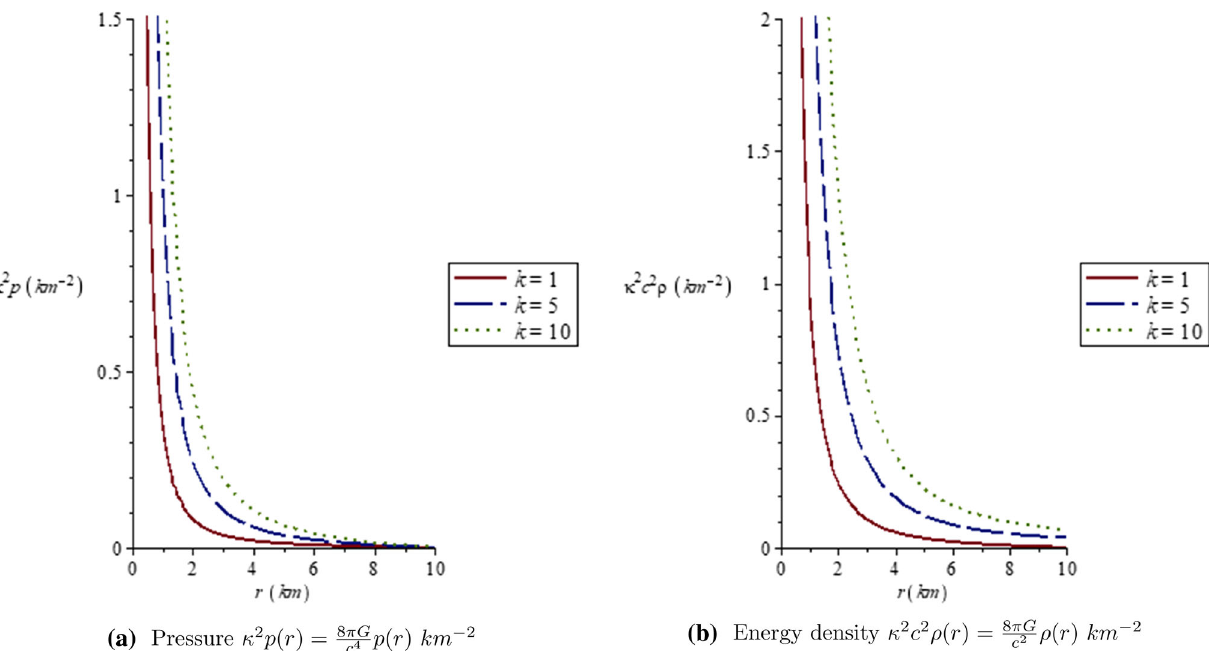
Fig. 1 Variation of the pressure ( a ) and energy density ( b ) as a function of the radial distance r inside the star with the boundary radius r b = 10 km and the parameter α =